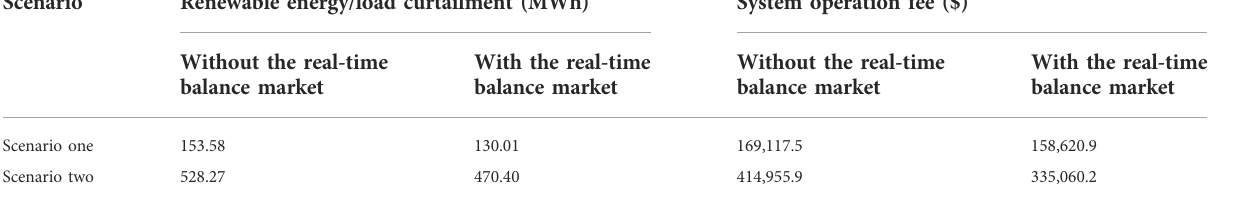
TABLE 3 System operation